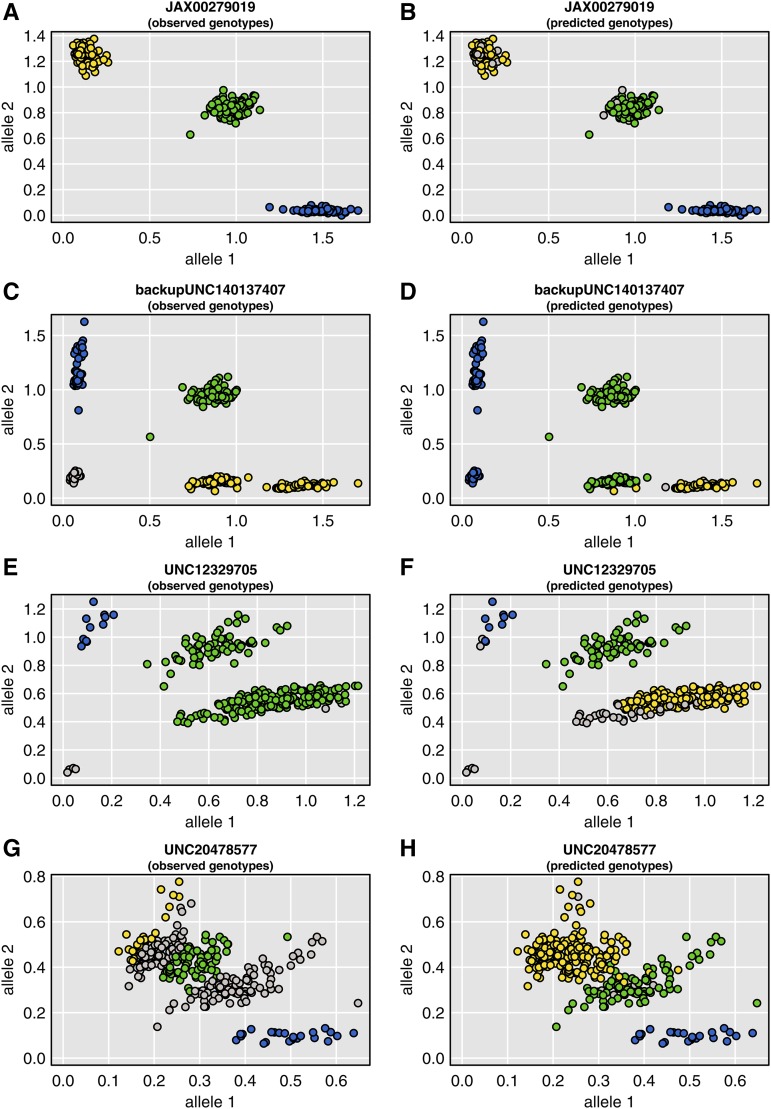
Allele intensity plots for four SNPs. In the left panels, points are colored according to the genotype calls, with yellow and blue being the two homozygotes and green being the heterozygote; gray points were not called. In the right panels, points are colored by the inferred SNP genotypes, given the multipoint marker data and the founders’ genotypes; gray points could not be inferred.